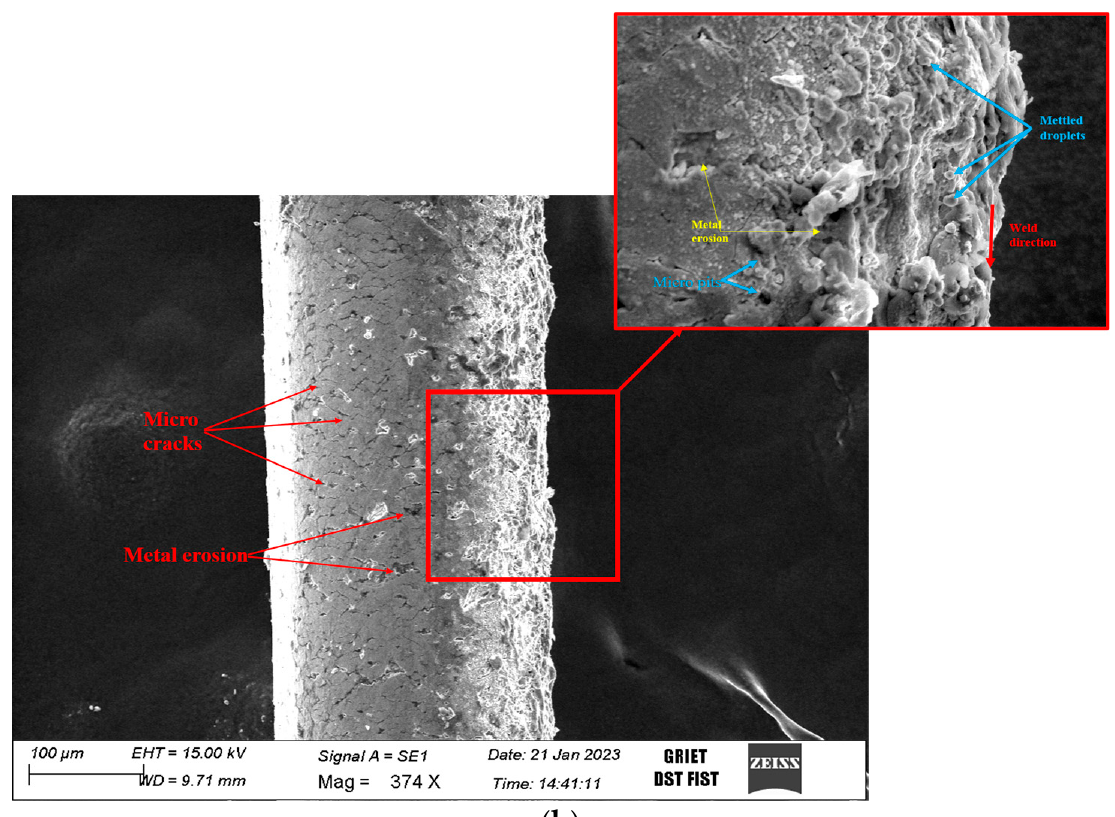
Figure 5. Work surface machining with various electrodes. ( a ) Untreated electrode. ( b ) Treated electrode.